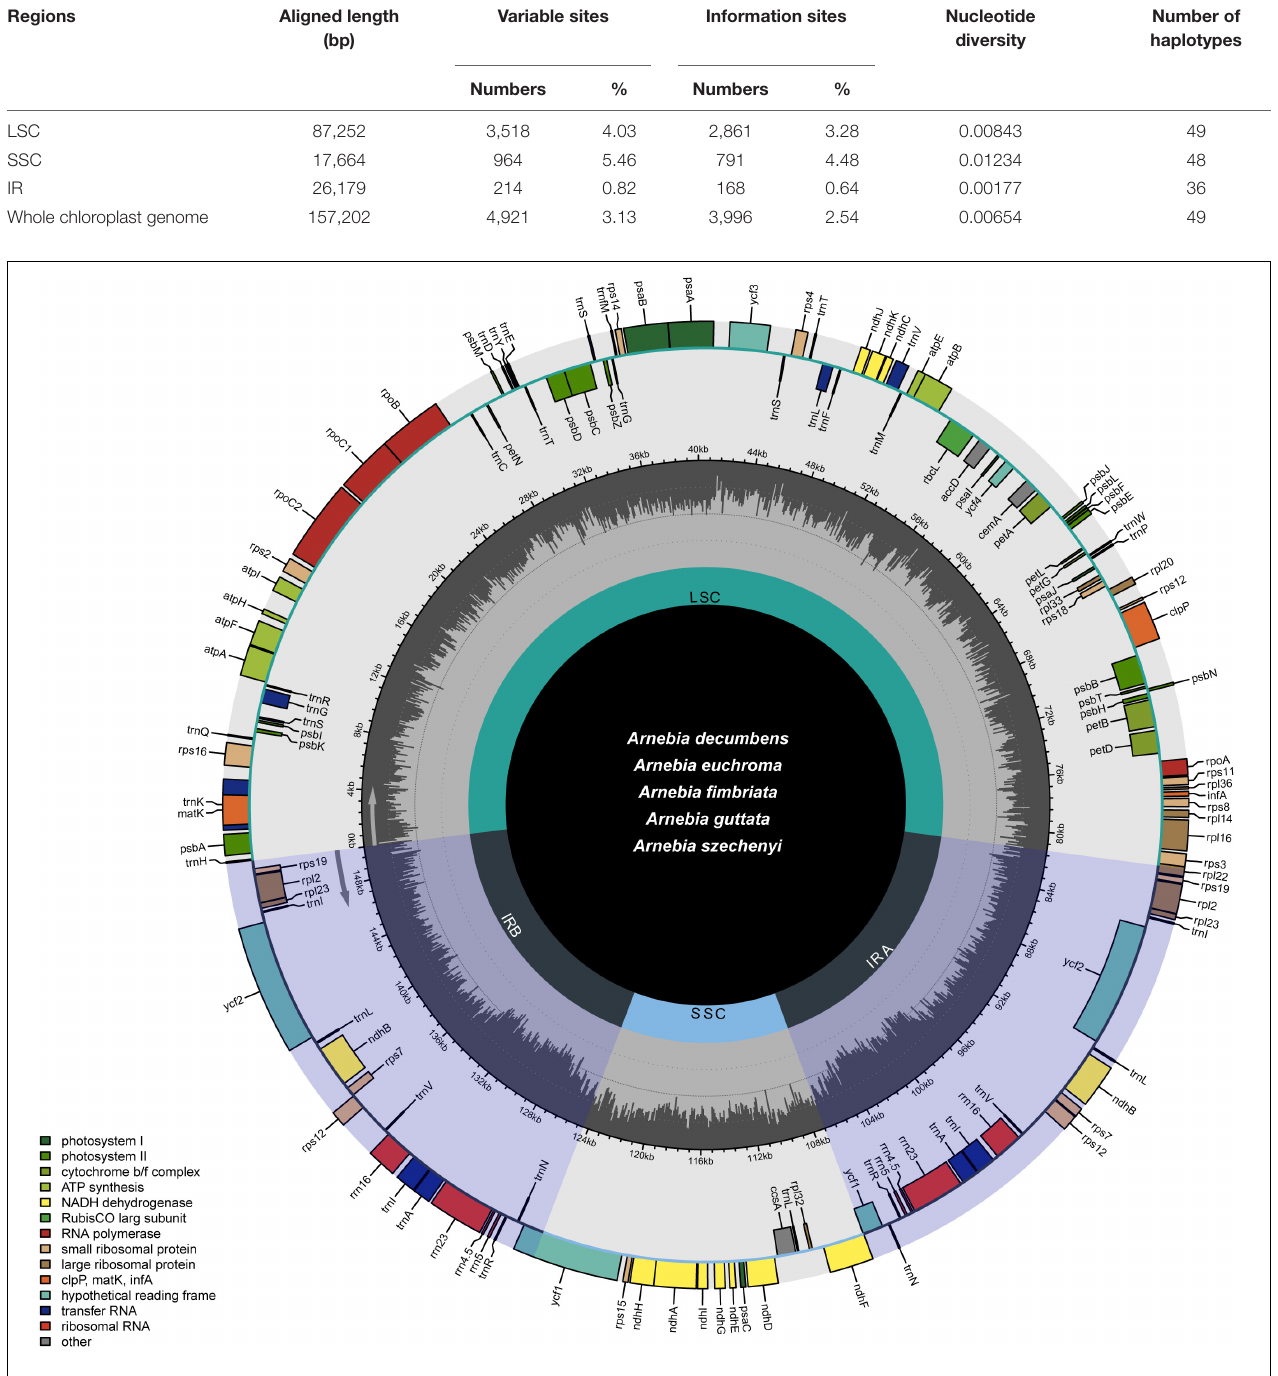
FIGURE 1 | Gene map of the Arnebia chloroplast genome. Genes are colored according to functional categories.